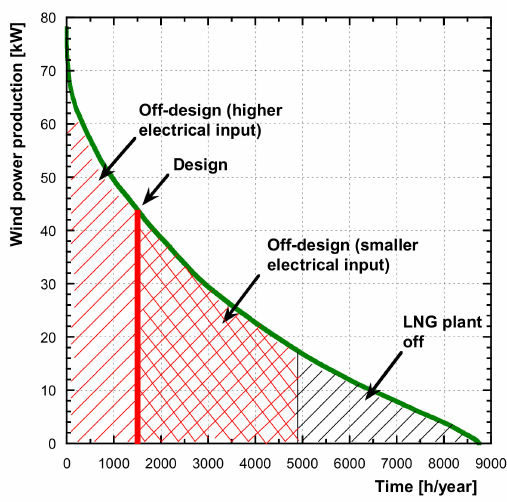
Figure 10. Hours of operation, during a year, of the LNG production